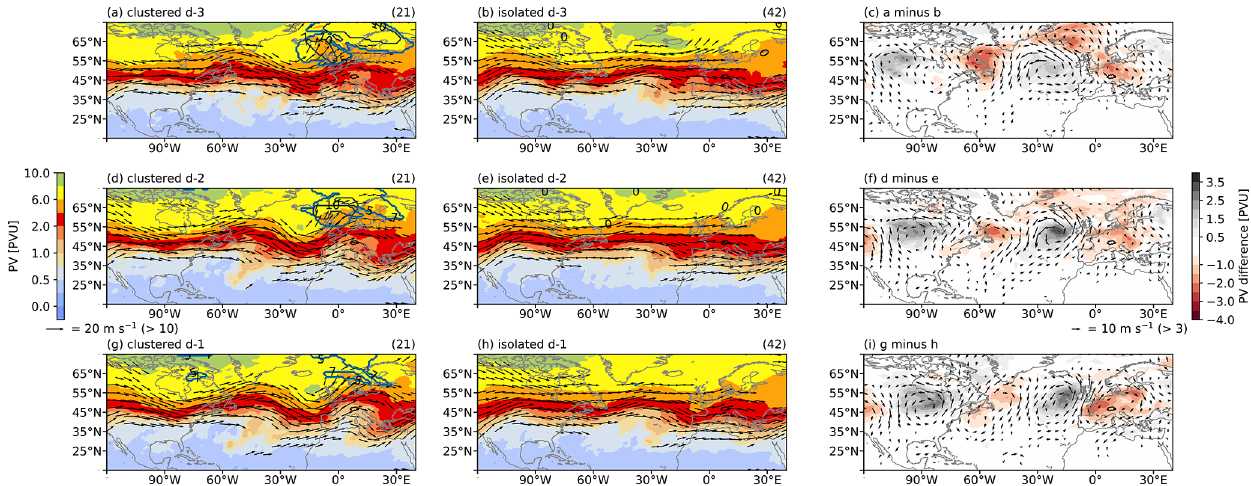
Figure 11. Composites of PV at 335K, winds at 250hPa, and atmospheric blocking frequency for the 3d prior to clustered (a, d, g) and isolated (b, e, h) hail days south of the Alps. The differences are shown in panels (c) , (f) , and (i) . See caption of Fig. 5 for